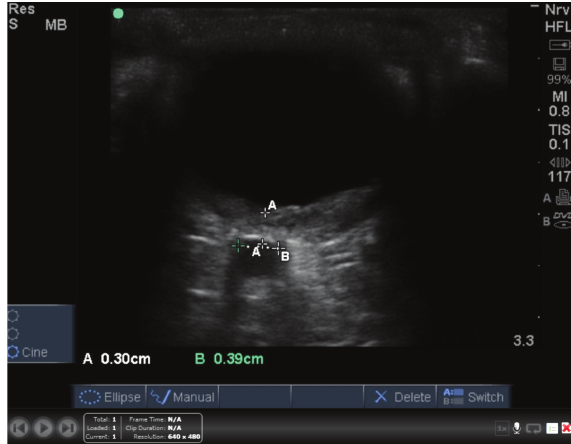
Figure 2: Left eye optic nerve sheath measurement, consistent with normal ICP.